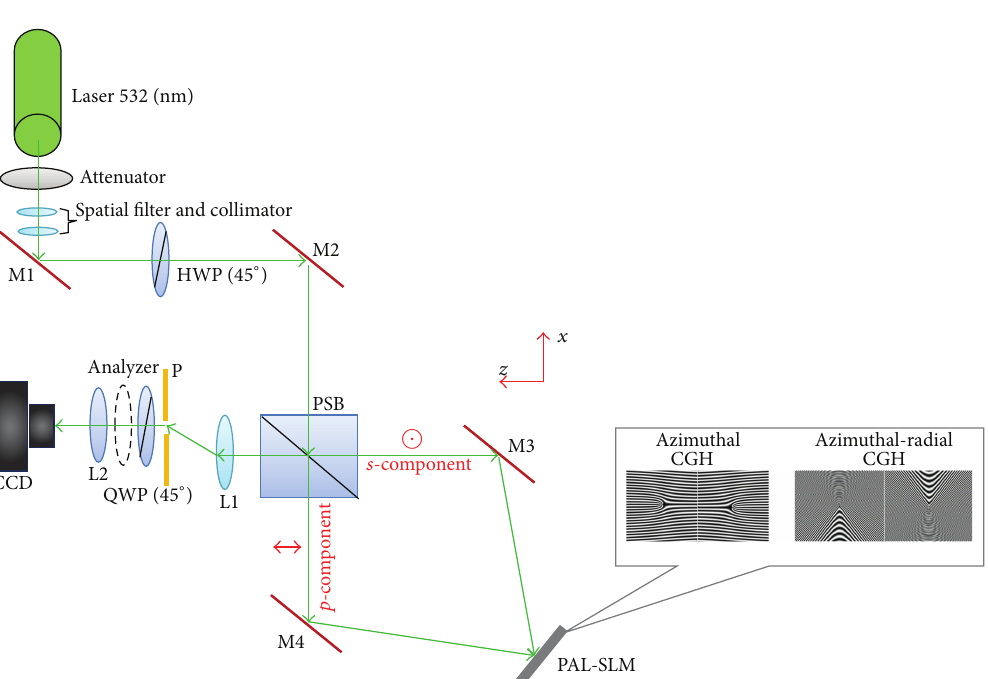
Figure 1: Schematic of experimental setup: attenuator; spatial filter; collimator; M, mirror; HWP, half-wave plate; PBS, polarizing beam splitter; PAL-SLM, optically addressable spatial light modulator; L, lens; P, iris diaphragm; QWP, quarter-wave plate; analyzer; and CCD. The inset shows the patterns of two compound holograms displayed on PAL-SLM for azimuthal (left) and azimuthal-radial (right) vector